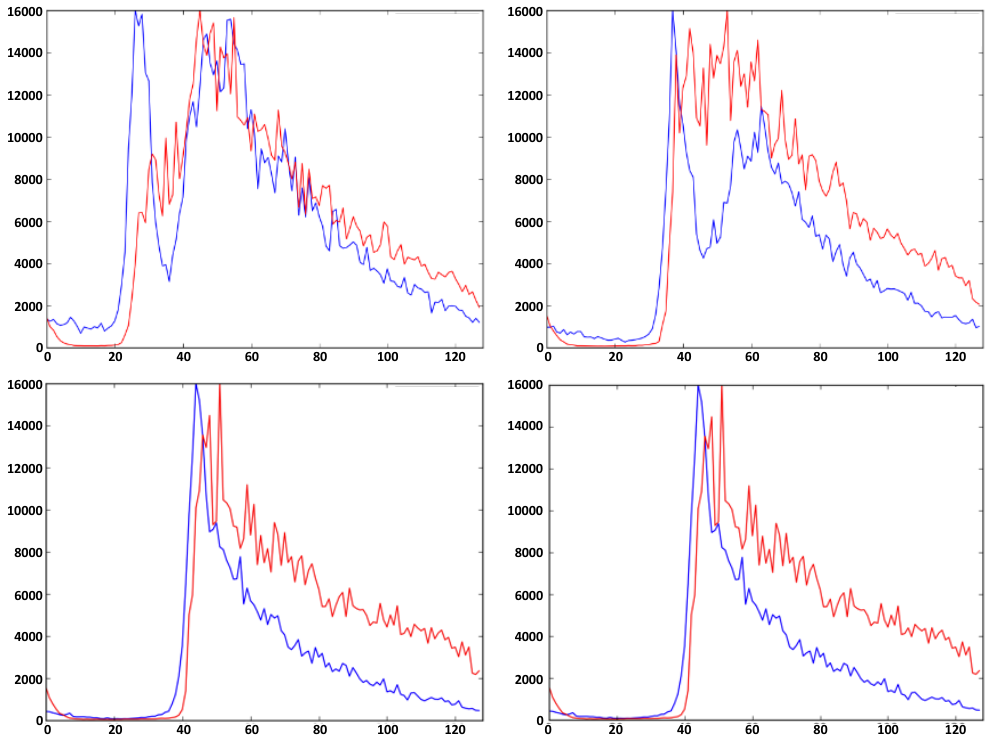
Figure 1. Experimental waveforms both in delay Doppler altimeter (DDA) mode (blue line) and conventional altimeter mode (red line) for various swell events detected by CryoSat-2 altimeter (track 681, cycle 030) as reported in [11].